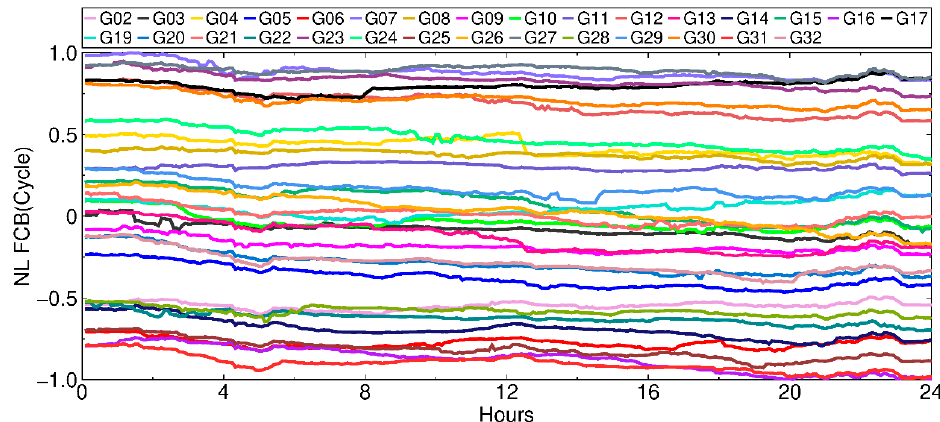
Figure 3. GPS NL FCB on DOY 328, 2018, referenced to G01.